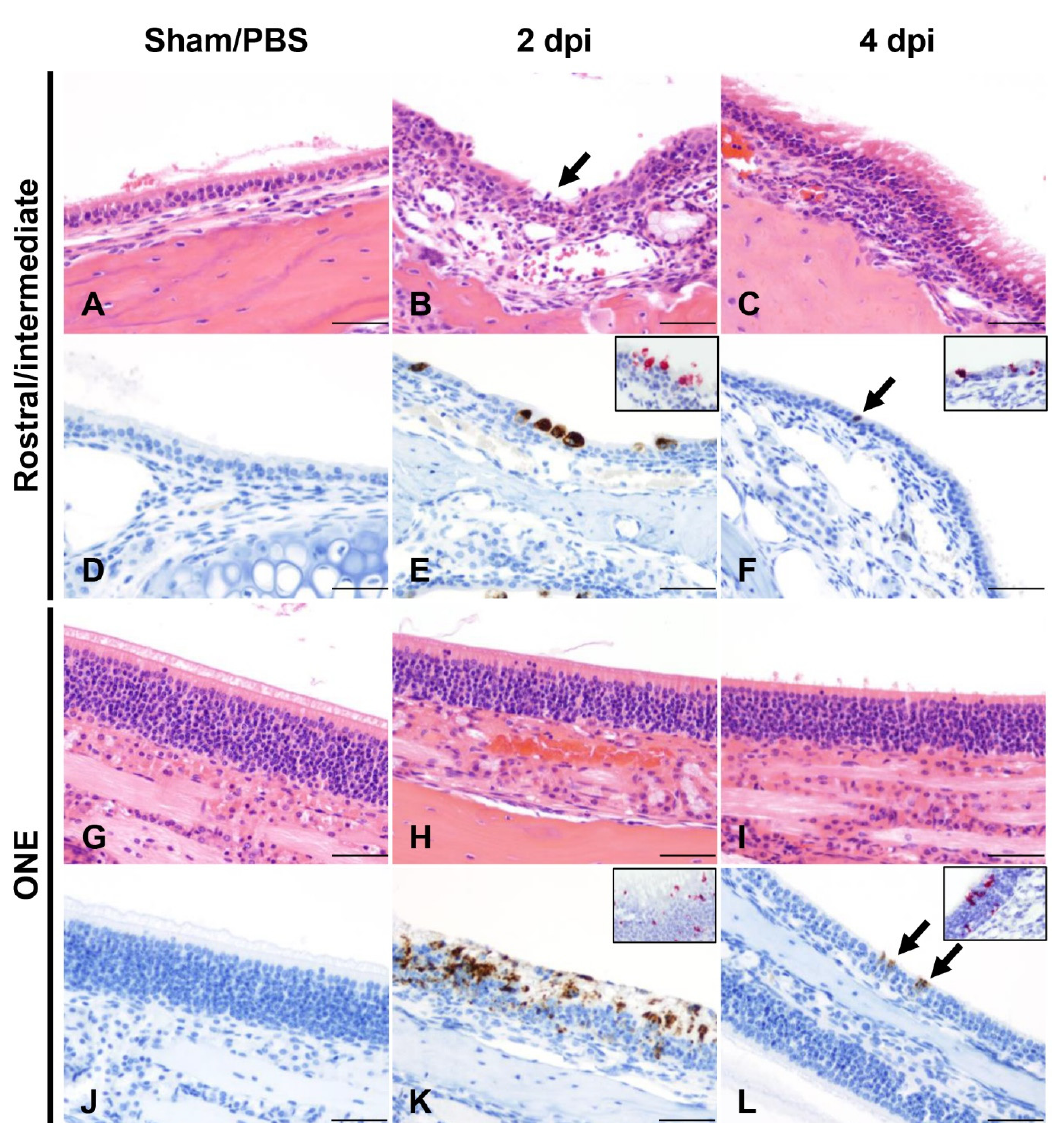
Figure 2. Temporal analysis of SARS-CoV-2 infection in the nasal cavity of K18-hACE2 mice. Histological changes, and viral protein (brown) and RNA (red) distribution and abundance were assessed in non-infected (Sham/PBS: A , D , G , J ; n = 3) and infected mice at 2 ( B , E , H , K , n = 3) and 4 ( C , F , I , L , n = 5) days following intranasal inoculation. At 2 dpi, neutrophilic rhinitis in the rostral and intermediate turbinates ( B , arrow) correlated with intraepithelial SARS-CoV-2 protein and RNA (E, inset). Viral protein and RNA were detected in the olfactory neuroepithelium (ONE, K and inset) in the absence of histologic lesions ( H ). At 4 dpi, only sporadically infected cells were noted in the epithelium lining the nasal turbinates and ONE (F and L, arrow, and insets) in the absence of histologic lesions (C and I). Sham/PBS-infected are depicted in A, D, G and J. H&E, DAB IHC (viral protein), and Fast Red ISH (viral RNA), 200X total magnification. Bar = 100 μ m.